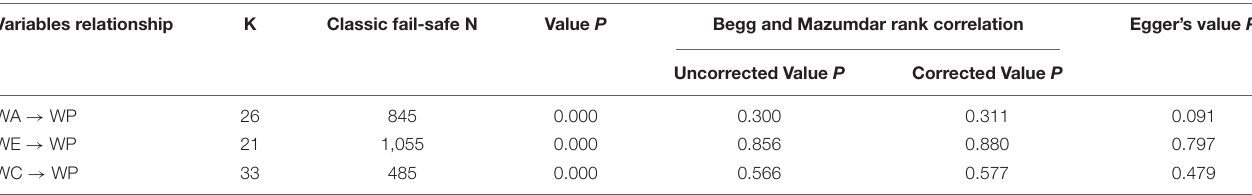
FIGURE 4 | Funnel plot of working compulsively on the work performance. TABLE 2 | Test results of publication